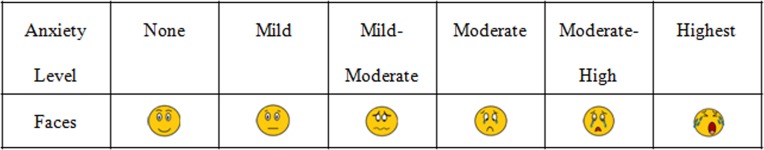
The proposed Visual Facial Anxiety Scale (VFAS).